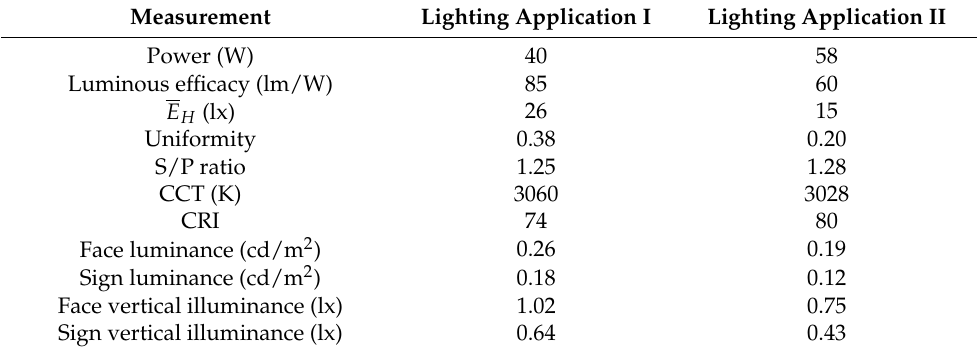
Table 2. Photometric data.